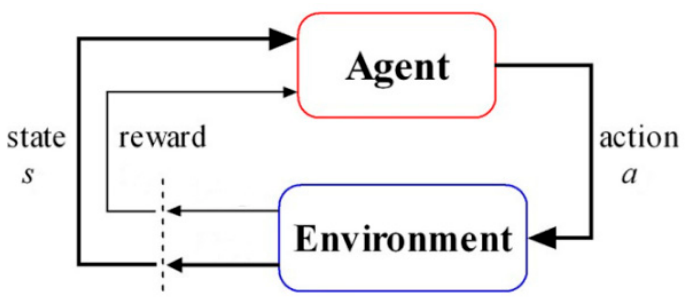
Figure 6. Main components of the iterative learning procedure.